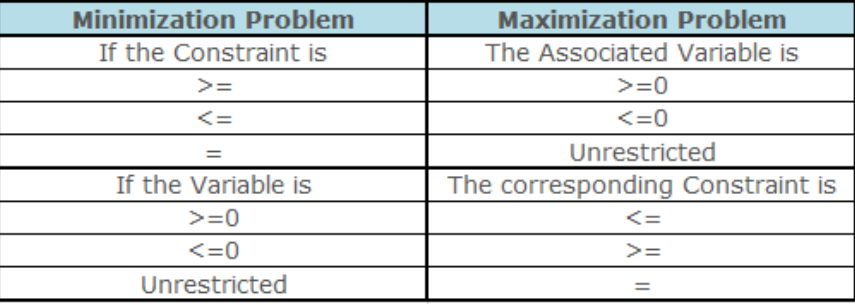
Table 1. Minimization/Maximization